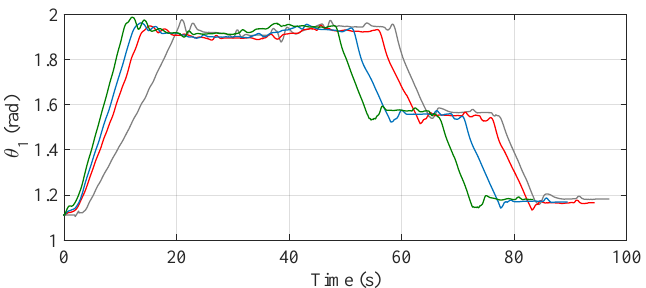
Figure 31. Behavior of the angular position ( θ 1 ) when the path is optimized with α = 0 ( — ), α = 0.5 ( — ) and α = 1 ( — ) and when the optimization is not considered ( — ).